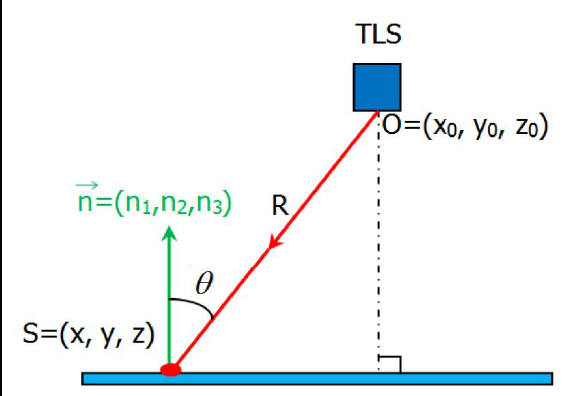
Figure 5. Schematic drawing of a system for calculating incident angle according to Tan and Cheng,